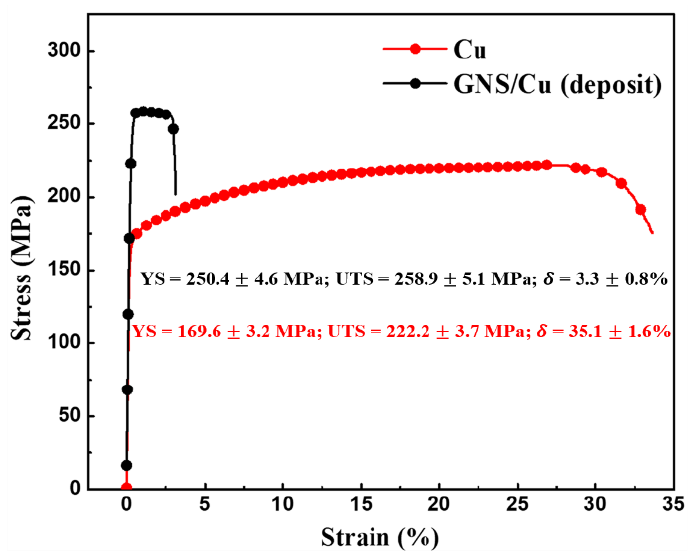
Figure 4. Room-temperature engineering strain – stress curve of pure Cu and GNS/Cu (deposit) com- posite.